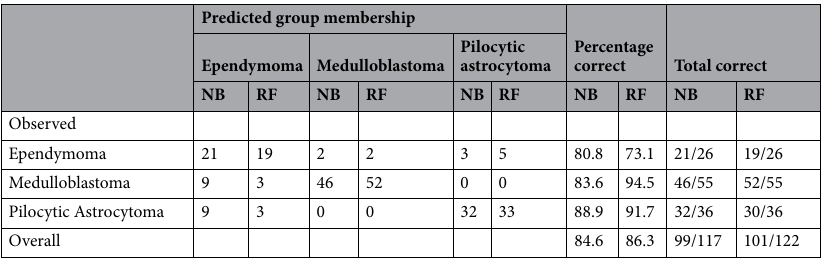
Table 2. The classification results using both Naïve Bayes (NB) and Random Forest (RF).